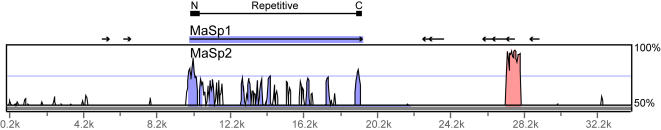
Global AVID alignment of L. hesperus genomic clones containing MaSp1 and MaSp2 visualized with VISTA.The MaSp1-containing clone was used as the reference sequence. Peak height corresponds to level of identity between the two clones. Regions exceeding 70% conservation over a window length of 100 bp are colored (blue for exons, red for non-coding sequence). The red peak corresponds to a putative transposable element found in both clones. Arrows mark open reading frames (ORFs) on the clone containing MaSp1.